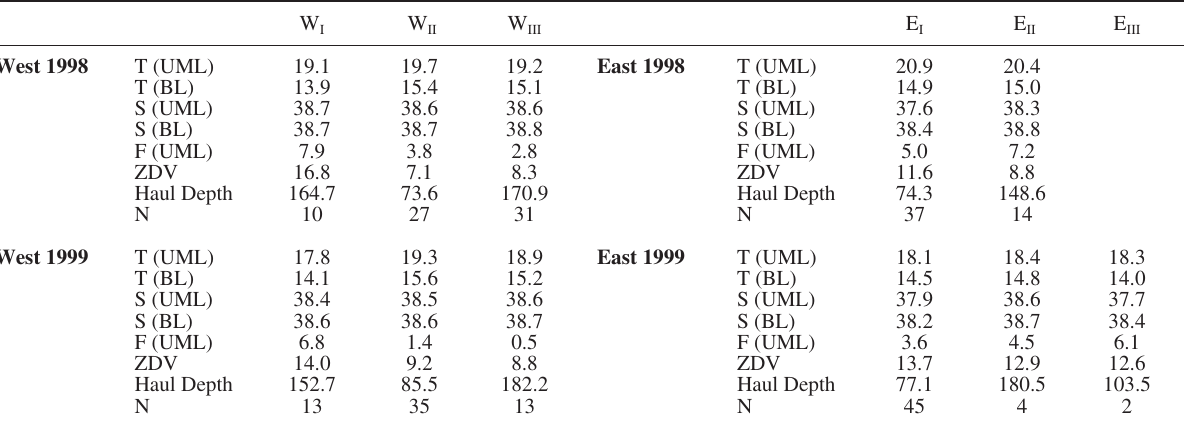
Table 3. – Mean values for temperature (T, °C), salinity (S), integrated fluorescence (F), haul depth (m) and zooplankton displacement vol- ume (ZDV, ml m -2 ) for the station groups defined by the cluster analysis. N, number of stations; UML, upper mixed layer; BL, bottom layer.